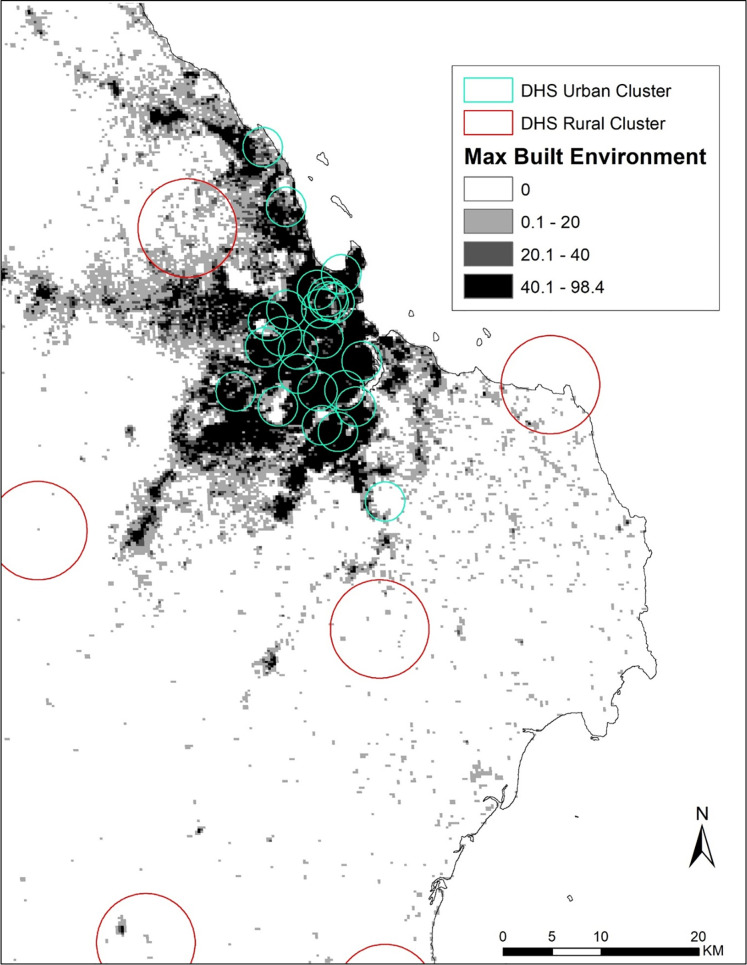
Spatial data layers, close-up of Dar es Salaam, Tanzania, Demographic and Health Survey 2010 and GHSL maximum built environment from 2014.